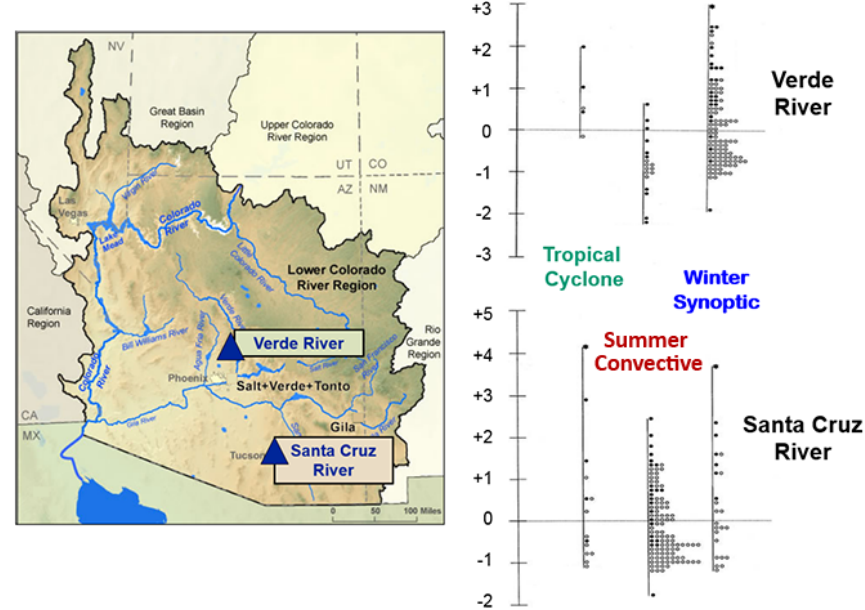
Figure 5. Stratification of flood events according to climatic mechanism. Climate-based flood heterogeneity is evident in two Arizona water- sheds when observed flood peak distributions are stratified according to the three dominant flood-producing mechanisms in the southwestern United States. Shown are histograms of instantaneous peaks above base, plotted as standardized dimensionless z scores for comparison. The Santa Cruz River at Tucson floods most frequently in response to summer convective thunderstorm rainfall, but the two largest peaks of record were produced by tropical-cyclone-enhanced rainfall and precipitation from winter synoptic storms, respectively. In contrast, in the Verde River below Tangle Creek, some 300km to the north, the most frequent and largest floods are produced by winter precipitation events (based on House and Hirschboeck,